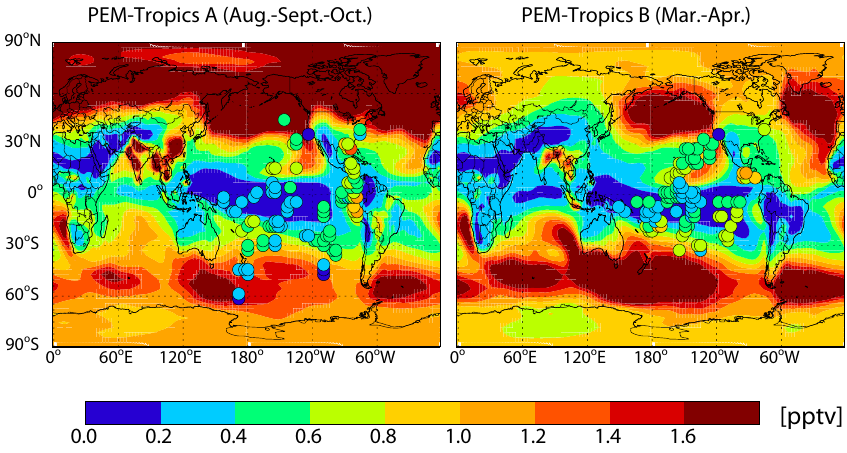
Fig. 3. Atmospheric concentrations of CH 3 I in the marine boundary layer. Circles are aircraft measurement data from PEM-Tropics A in August-October (left) and PEM-Tropics B in March-April (right). The aircraft and model data are averaged between 0 and 1km for boundary layer